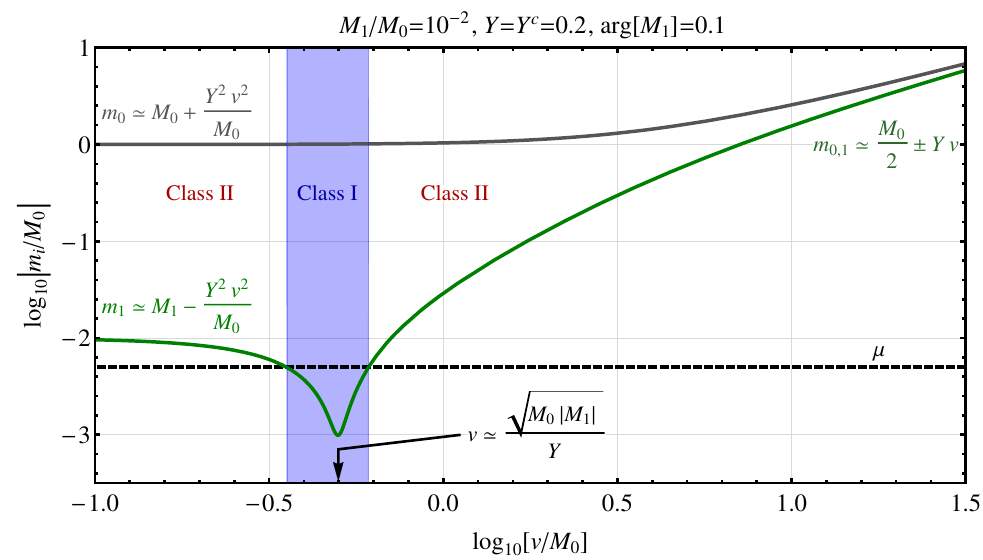
Figure 3 . Mass eigenvalues m i = m 0 ; m 1 (gray, green) of neutral brane fermions N 0 , N c , N 1 , 0 f g H v , with quantities on both axes normalized to the and N c , as a function of Higgs vev 1 hj ji (cid:17) bare vector mass M 0 on a logarithmic scale. For simplicity, we pick Y = Y c such that each mass M 1 > (cid:22) > 0. For m 2 > 0 and v = 0, there is no eigenvalue is two-fold degenerate, assume M 0 > H j j M 1 mixing and the mass eigenvalues are just the bare masses M 0 and , both larger than the scale j j of brane-bulk mixing (cid:22) . For Y Y c v 2 & M 2 , both mass eigenstates are again much heavier than 0 (cid:22) . For Y Y c v 2 . M 2 m 1 , however, the lighter mass eigenvalue can drop below (cid:22) for su(cid:14)ciently 0 j j p v (cid:3) M 0 M 1 =Y Y c , at which point mixing of the light state with the bulk small arg[ M 1 ] near v (cid:24) (cid:17) j j . (cid:22) are categorized m 1 ( v ) fermion becomes important. Vacua with v su(cid:14)ciently near v (cid:3) such that j j in Class I, all others in Class